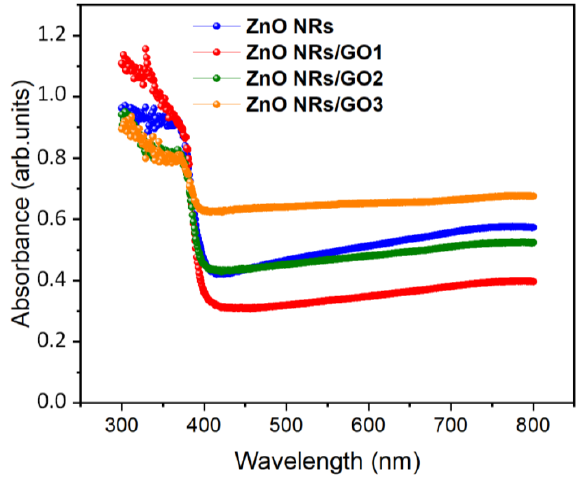
Nanomaterials 2020 , 10 , x FOR PEER REVIEW Figure 8. Absorbance spectra of ZnO NRs and ZnO NRs / GO nanocomposites.